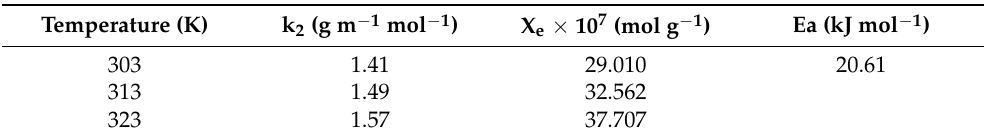
Table 1. Pseudo second order model parameters and activation energy for arsenate adsorption on MgO-IBC composite.